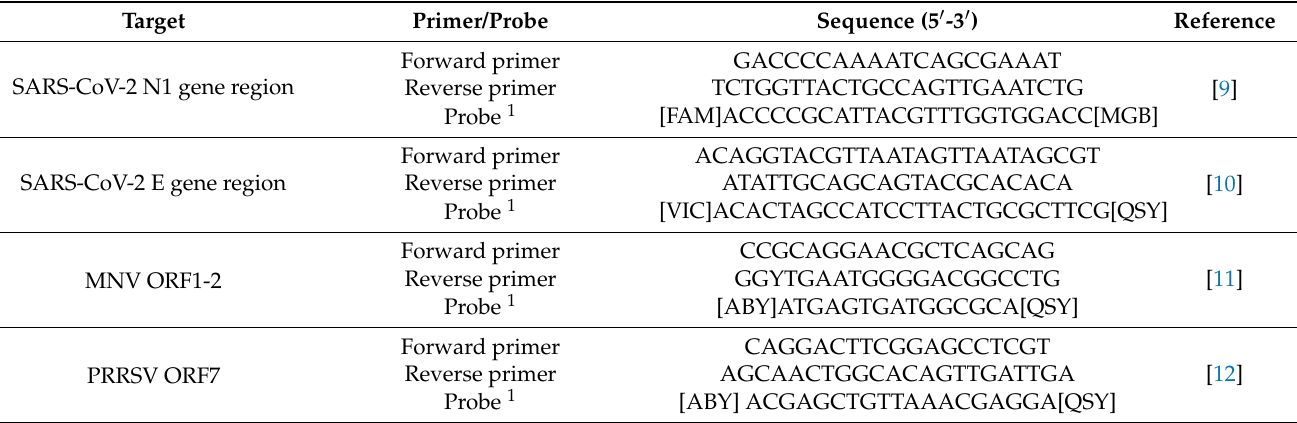
Table 1. Primers, probes and reaction conditions used for the qRT-PCR. MNV: murine norovirus; PRRSV: porcine respiratory and reproductive syndrome virus; ORF: open reading frame. Target Primer/Probe Sequence (5 (cid:48) -3 (cid:48) ) Reference Forward SARS-CoV-2 N1 gene region